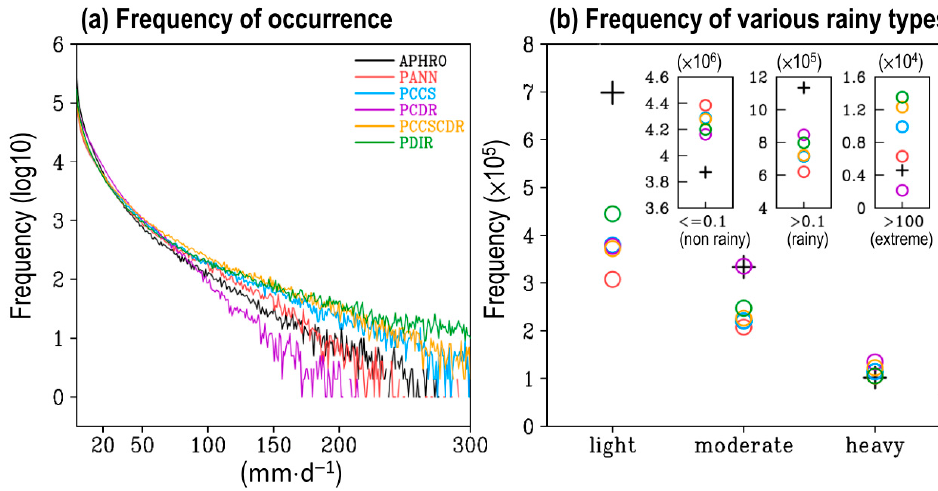
Figure 8. ( a ) The frequency of daily precipitation events as estimated from Figure 7b at different intensity; and ( b ) the frequency of various types of precipitation events estimated from ( a ): non